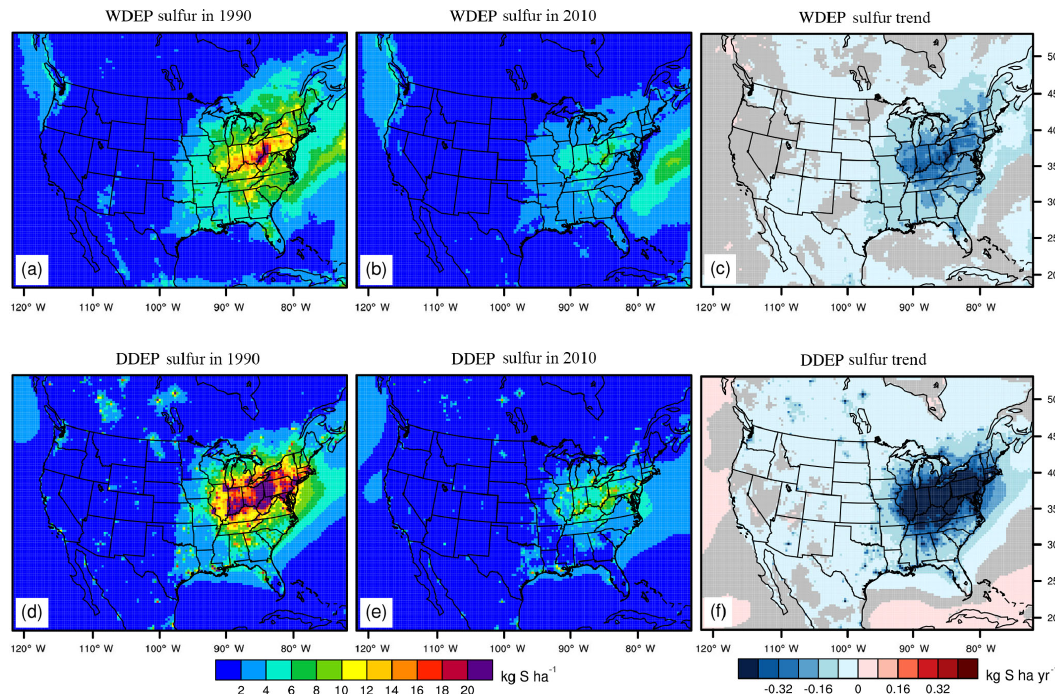
Figure 7. As in Fig. 6 but for sulfur. The units are kgSha − 1 for (a, b, d, e) and kgSha − 1 yr − 1 for (c, f) .